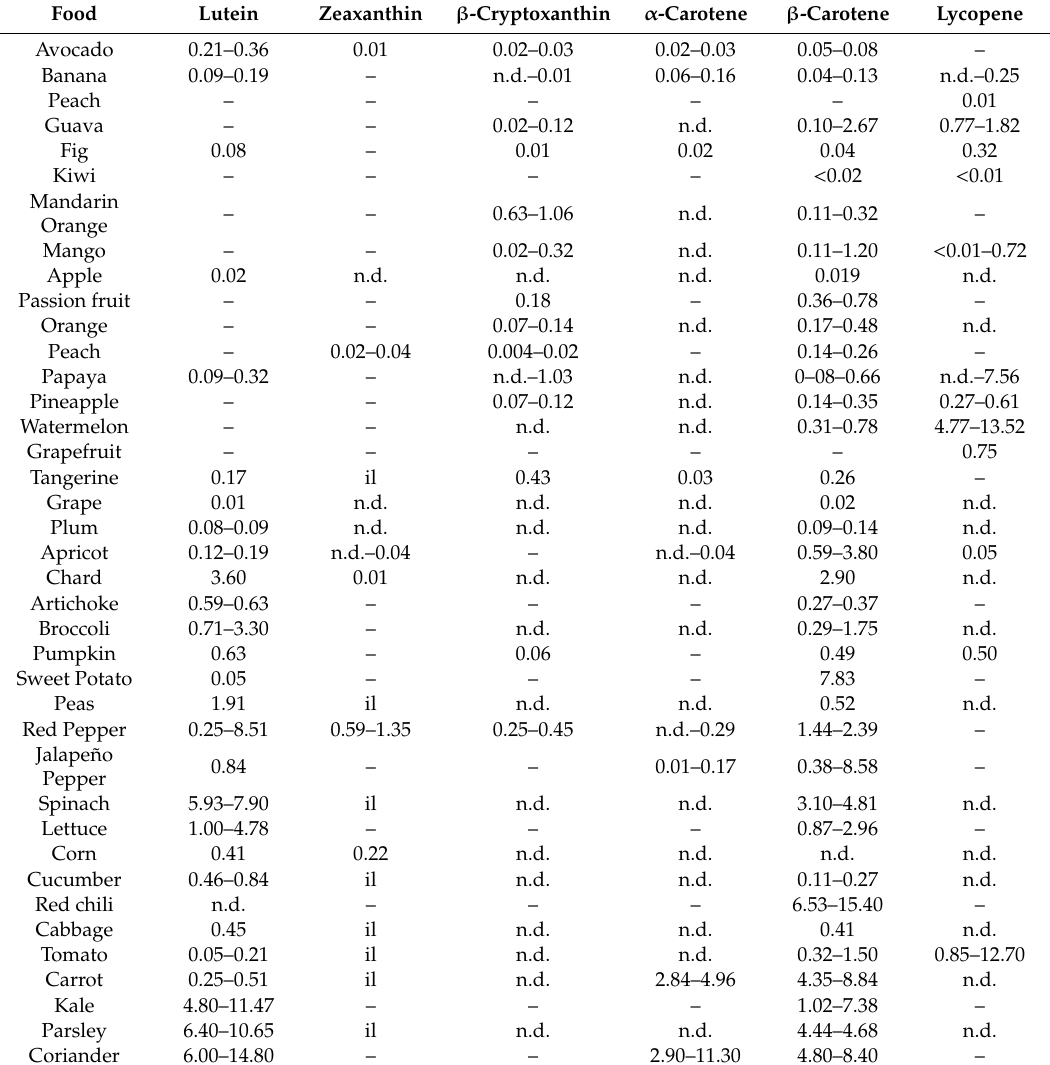
Table 1. Data on the contents of major carotenoids in fruits and vegetables common in the human diet (mg / 100 g)